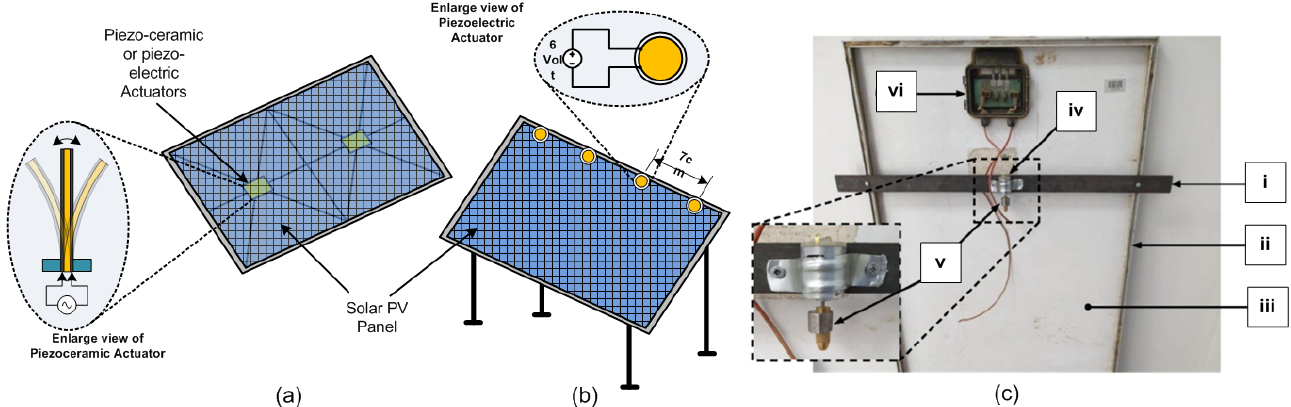
Figure 7. Vibration-based solar panel cleaning applications: ( a ) Piezo-electric actuator located on the back side of the panel; ( b ) Piezo-electric actuator located on the surface of the panel; ( c ) Eccentric Rotating Mass (ERM) motor actuator located on the back side of the solar panel, where (i) iron base for motor, (ii) solar panel frame, (iii) back side of the panel, (iv) ERM motor, (v) ERM, and (vi) connection box